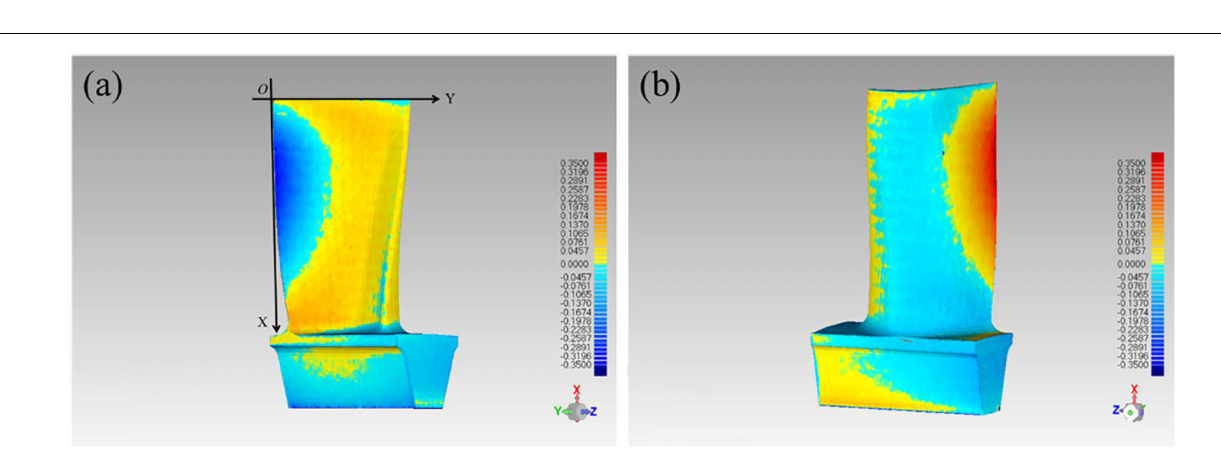
FIGURE 6 | Misorientation number of the blade, (A) at the leading edge, (B) at the trailing edge.